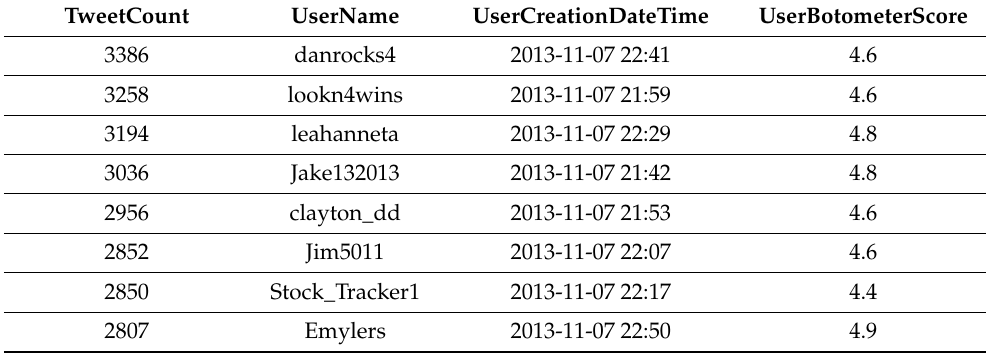
Table 1. Eight $/#TSLA accounts created within 75 min on 7 November 2013 (with Botometer scores).